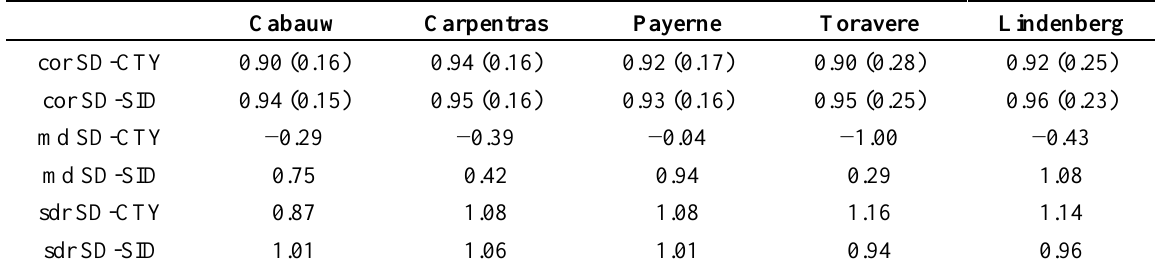
Table 4. Comparison of daily SD data for SD-CTY, SD-SID, and station data. Shown are the Pearson’s correlation (cor), the mean difference satellite product minus station (md), and the ratio of the satellite product to station standard deviations (sdr). To estimate the influence of the annual cycle on cor, the ratio of the explained variances for a sine curve and for the satellite product are given in brackets (for details see Section 4.2). Cabauw Carpentras Payerne Toravere